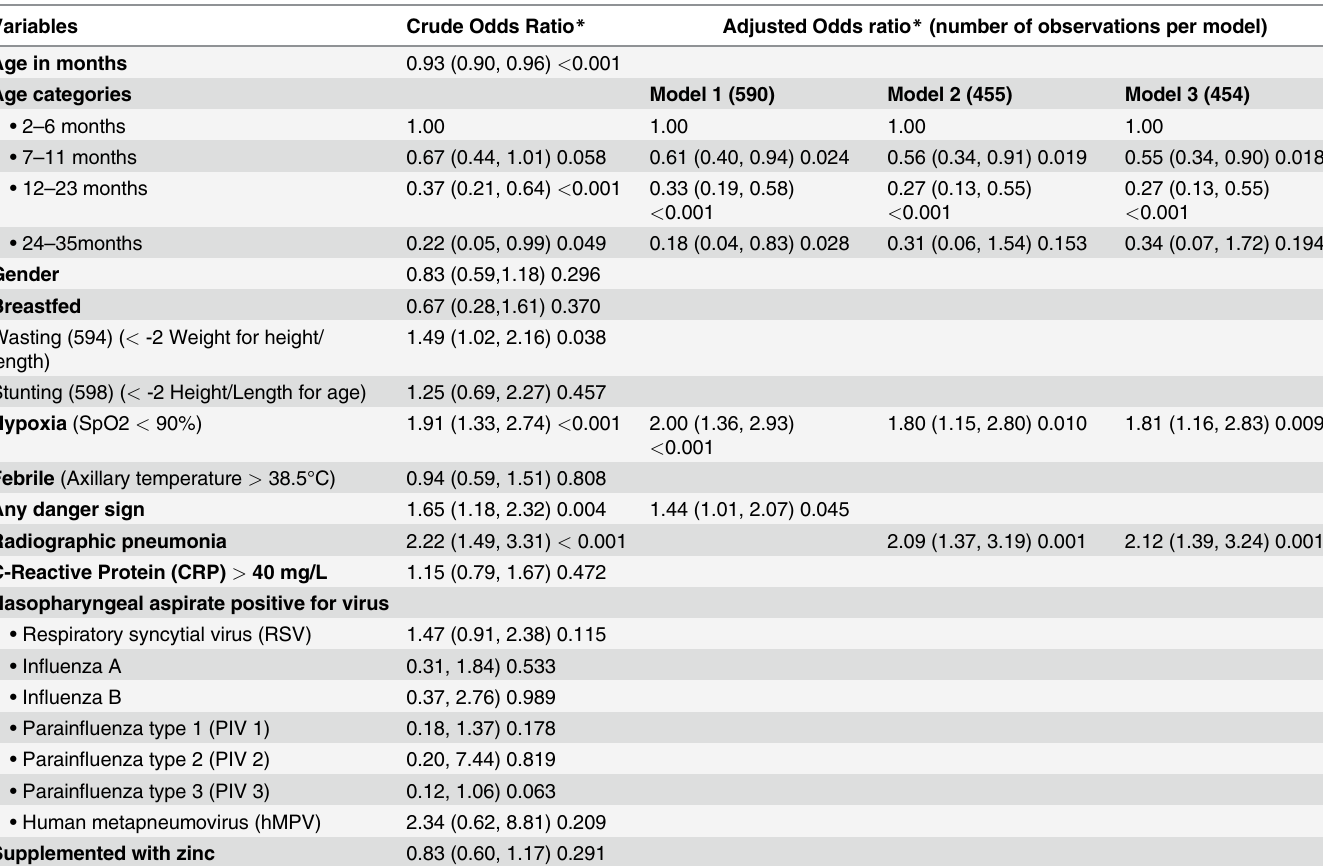
Table 3. Predictors of Treatment failure of illness episode in children 2 – 35 months hospitalized with WHO defined Severe Pneumonia